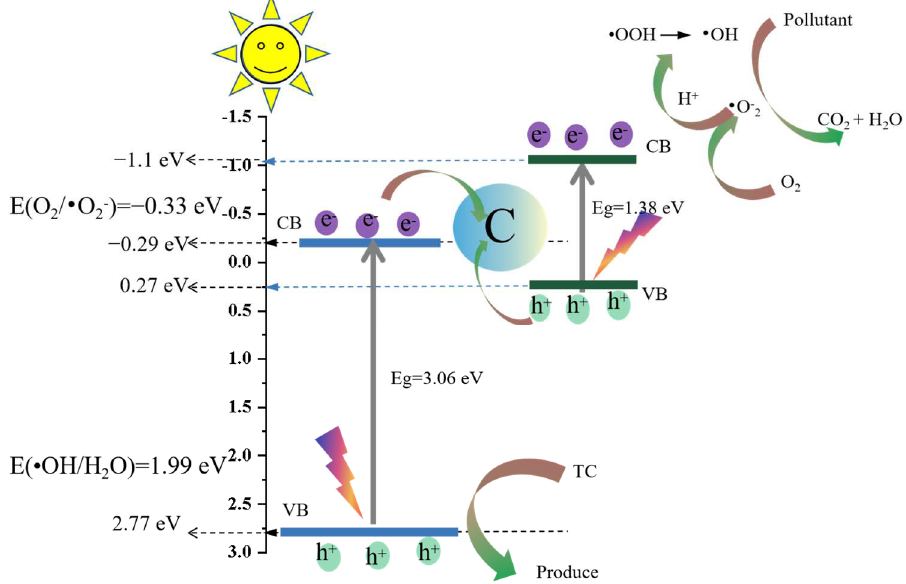
Figure 11. ZnO, MnO 2 band structure ( a ); ZnO and MnO 2 charge distribution on contact ( b ); ZnO and MnO 2 carrier transport mechanism ( c ); ZnO‐C/MnO 2 heterojunction Z‐scheme carrier transport mechanism ( d ).